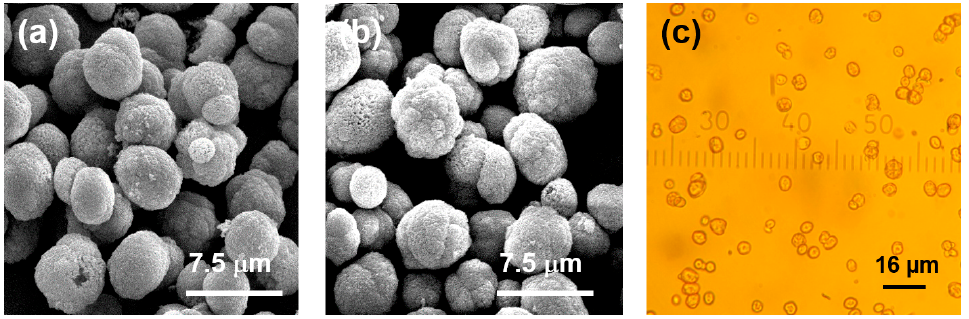
Figure 6. SEM ( a , b ) and optical ( c ) microscopy images of CaCO 3 crystals with adsorbed ( a ) and co-synthetized mucin ( b , c ).